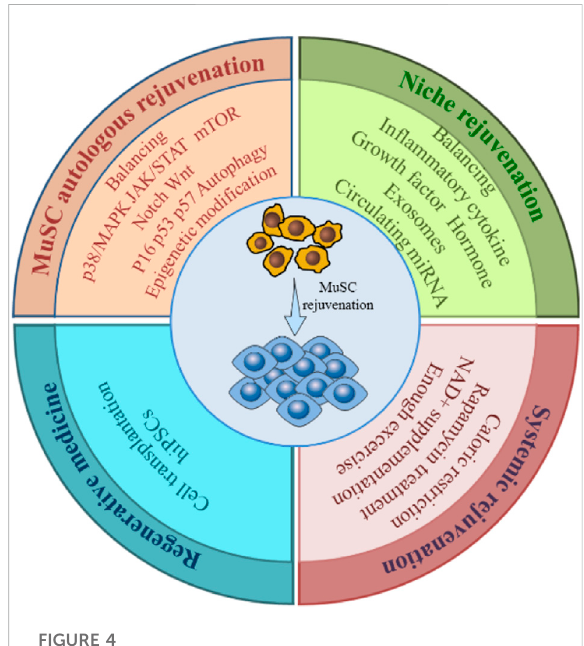
FIGURE 4 Rejuvenationstrategies for MuSC. To restore thenumberand function of the aging MuSC requires restoring the overall rejuvenation of MuSC itself, niche and the system, by balancing dysregulated signaling pathways, cytokines, cellular metabolism, and genetic modi fi cations etc., through various means. Cell transplantation and hiPSCs technologies in regenerative medicine also offer new approaches to MuSC